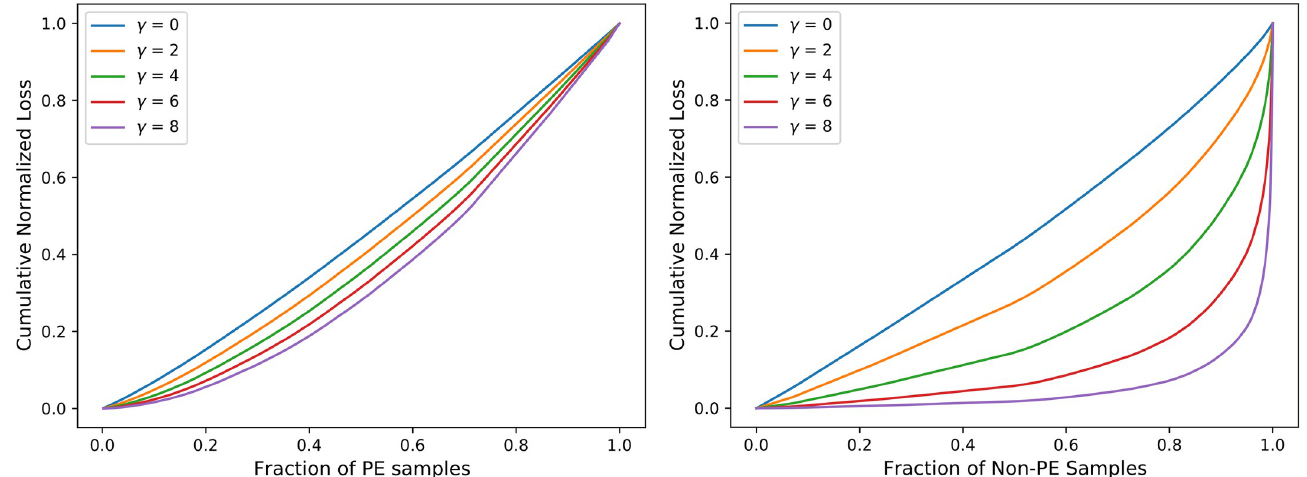
Fig 19. Cumulative distribution functions of the normalized loss PE (positive) and Non-PE (negative) samples for various γ values and α = 0.5 for Oklahoma PUDF.